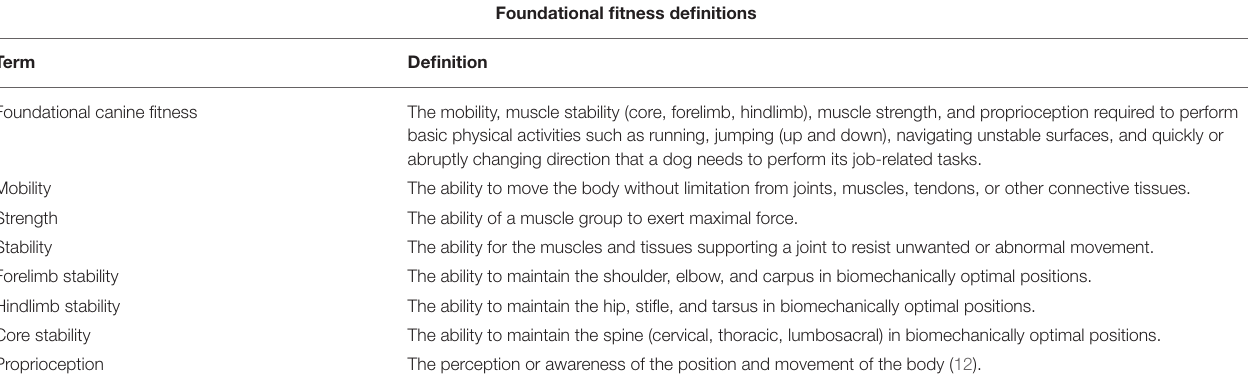
TABLE 1 | Definitions of foundational canine fitness